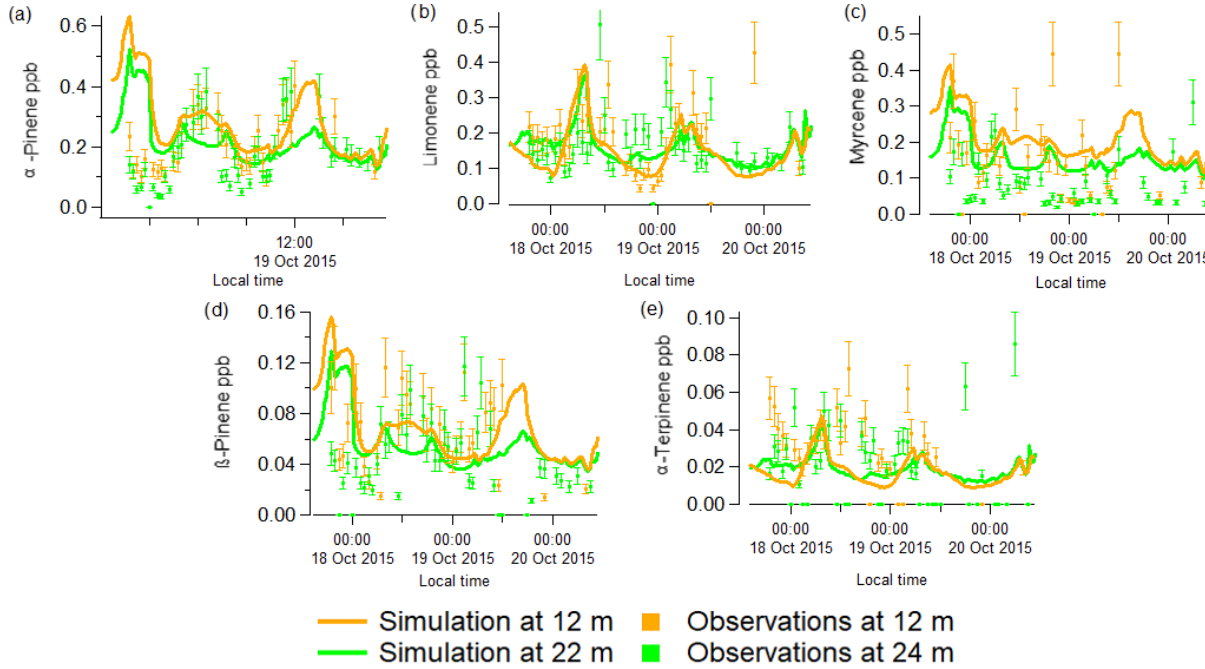
Figure 6. Comparison between simulated results (solid lines) for 12.5 (orange) and 22.5m (green) from the MLC-CHEM, with the GC-FID speciated mixing ratios measurements (in ppb) for α -pinene (a) , limonene (b) , myrcene (c) , β -pinene (d) and α -terpinene (e) at ATTO from 17 to 20 October 2015. The error bars represent the 20% uncertainty involved in the GC-FID